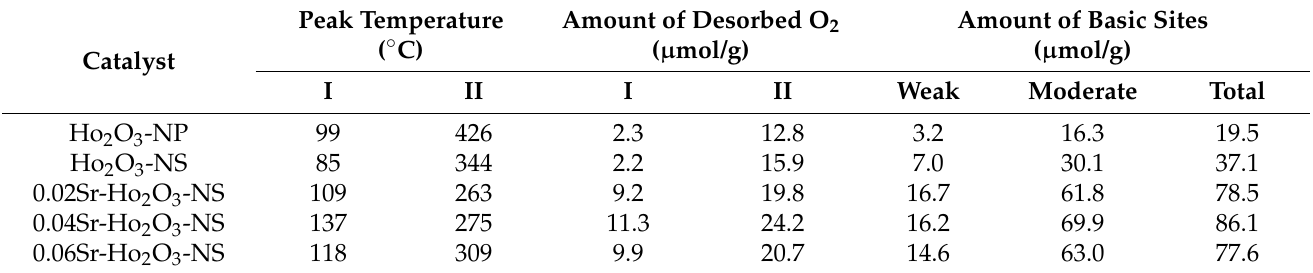
Table 3. O 2 -TPD and CO 2 -TPD data of the Ho 2 O 3 -based